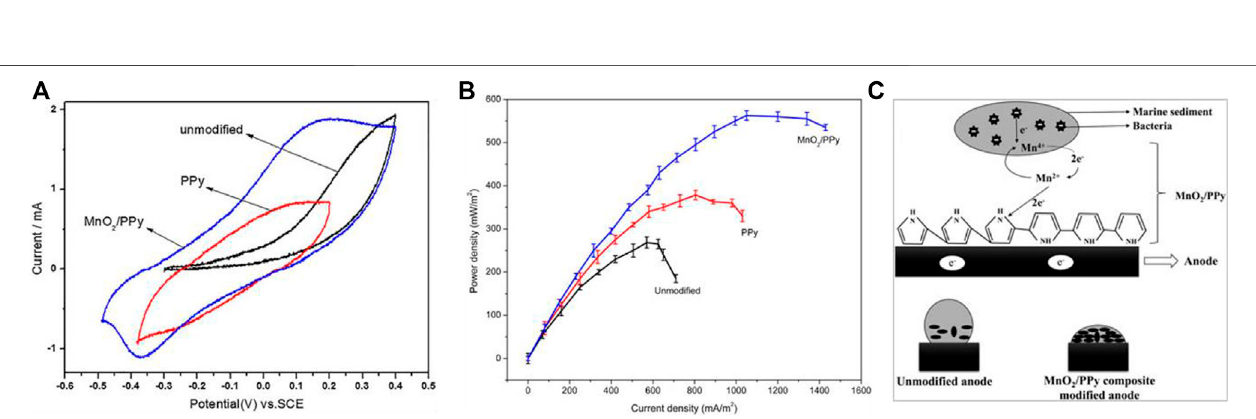
FIGURE 10 | (A) Cyclic voltammetry plots, (B) cell power density curves, and (C) electron transfer mechanism of different anodes (Chen et al., 2017b).